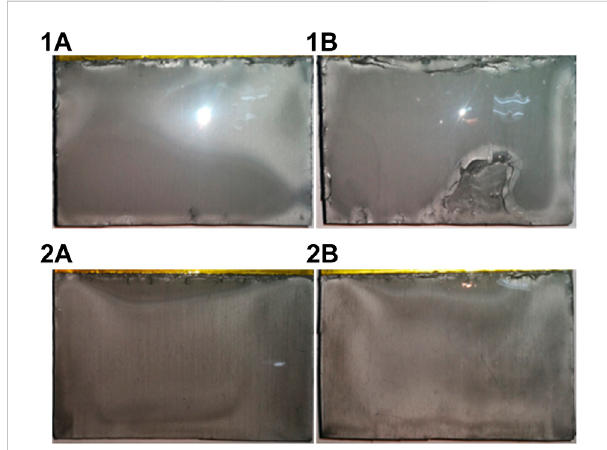
Optical photos of Al-Li alloy deposits obtained from urea-LiCl by Galvanostatic electrolysis at 20 A for 1 h at 373 K. 1A and 2A are two sides of the cathode 1; 1B and 2B are two sides of the cathode